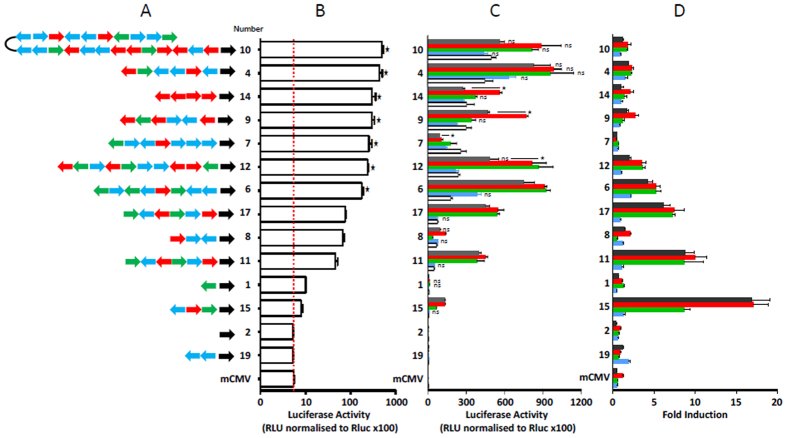
Structure and function of 4bp composite synthetic promoters.Compact randomly assembled 4bp synthetic promoter sequences are schematically represented in (A) (TFBS: AP-1 (red), NF-κB (green), HRE (blue) the arrow direction indicates the orientation of TFBS and the black arrow represents the mCMV promoter). Basal promoter activity was assessed in transfected non-stimulated 293T cells and is illustrated in (B), comparison of basal expression of all promoters with the mCMV group was performed by 1 way ANOVA which showed significant differences. A post-hoc Tukey test was then performed to determine significant differences from the mCMV promoter and where p < 0.05 this is indicated by ★. (C) shows the luciferase activity upon stimulation of cells and these changes are expressed as fold changes from basal activity in (D). The responsiveness of each promoter in C to stimulation was also analysed by 1 way ANOVA (within each promoter). A post-hoc Šidak test was then performed to determine the level of significance of mean values above the activity of the unstimulated promoter. Where the difference from unstimulated promoter activity was not significant (p > 0.05) this is indicated by ns. When the activity with combined stimulation (grey bars) was significantly (p < 0.05) lower than the highest activation caused by an individual stimuli this is indicated by ★.